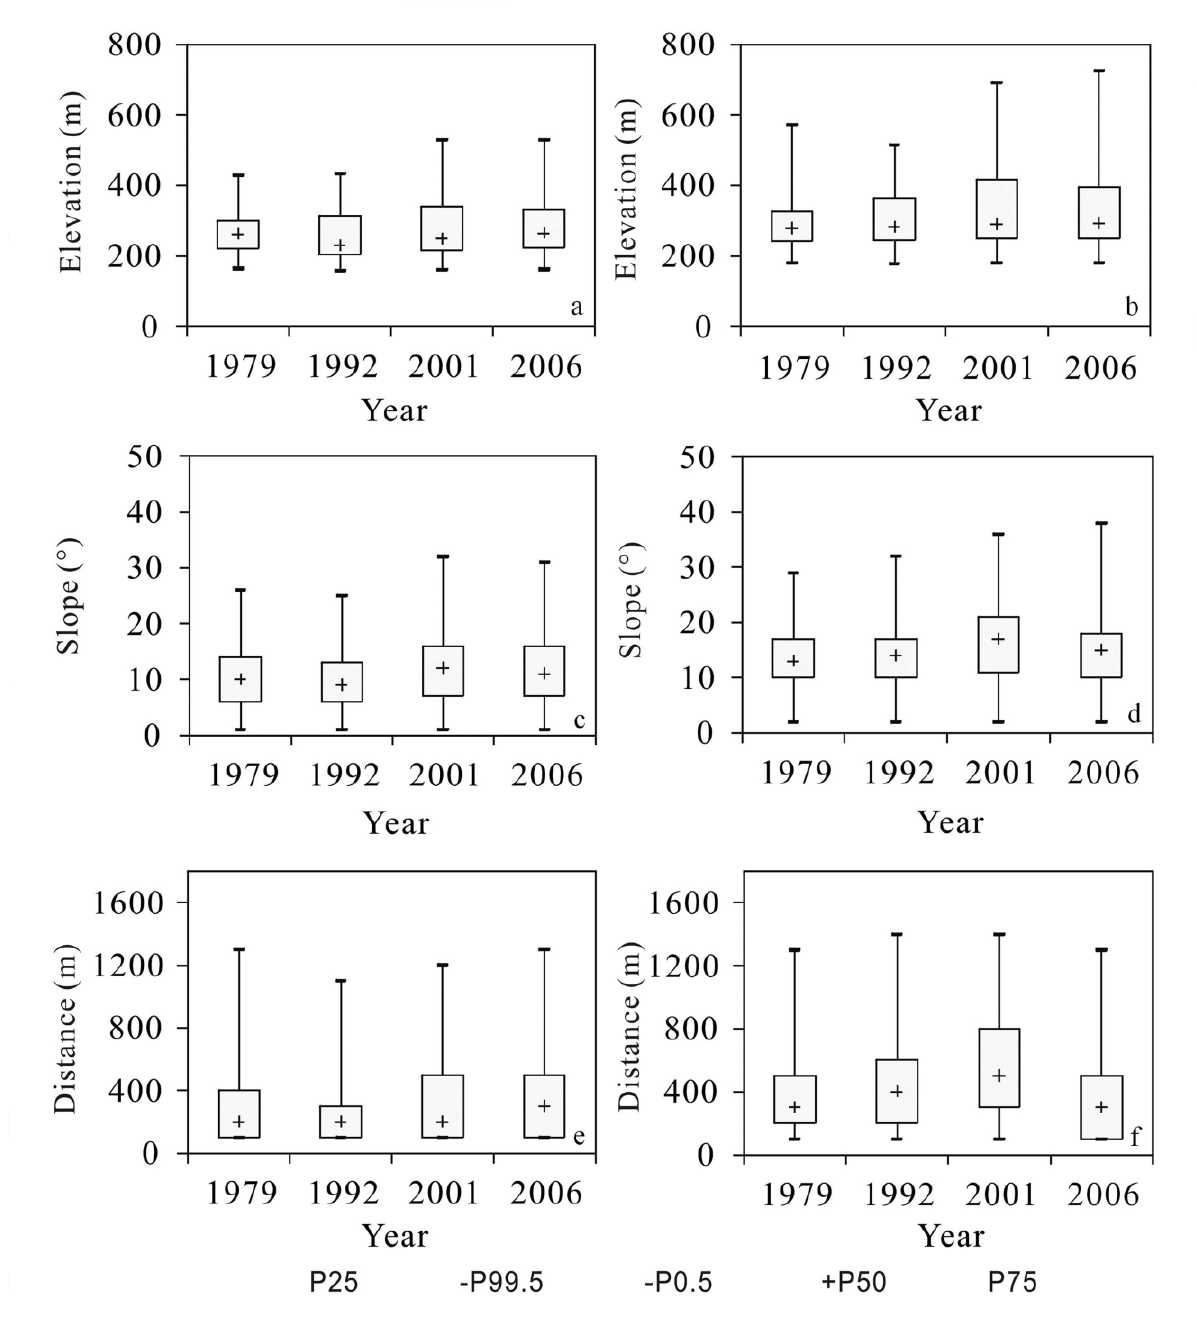
slope and distance to road in four study periods. Left side: agricultural land; Right side: open canopy